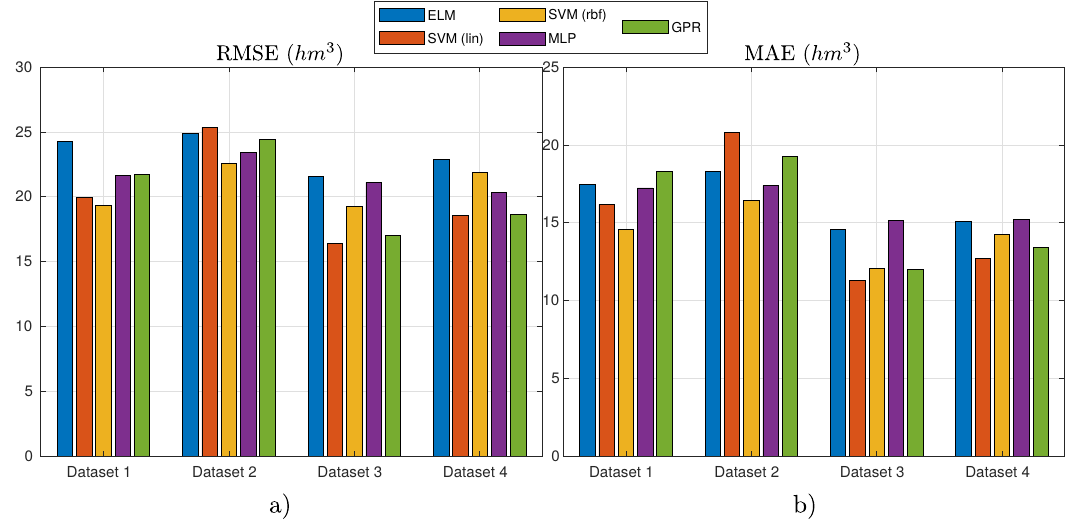
Figure 9. Results of the different ML regression techniques for different variables considered (datasets) in the case of standard data (all seasons) and temporal partitioning: ( a ) the RMSE results; and ( b ) the MAE